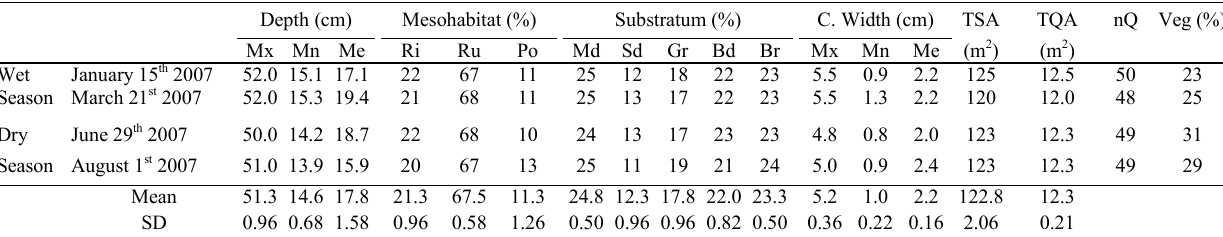
Table 2. Environmental characterization of the study site at Mato Grosso stream considering (1) maximum (Mx), minimum (Mn) and mean (Me) depth; (2) percentual values of mesohabitat cathegories: riffles (Ri), runs (Ru) and pools (Po); (3) percentual values of substratum type: mud (Md), sand (Sd), gravel (Gr), boulder (Bd), and bedrock (Br); (4) maximum (Mx), minimum (Mn), and mean (Me) channel width ; total sampled area (TSA); total quadrat area (TQA); total of analysed quadrats (nQ) and percentual of aquatic vegetation